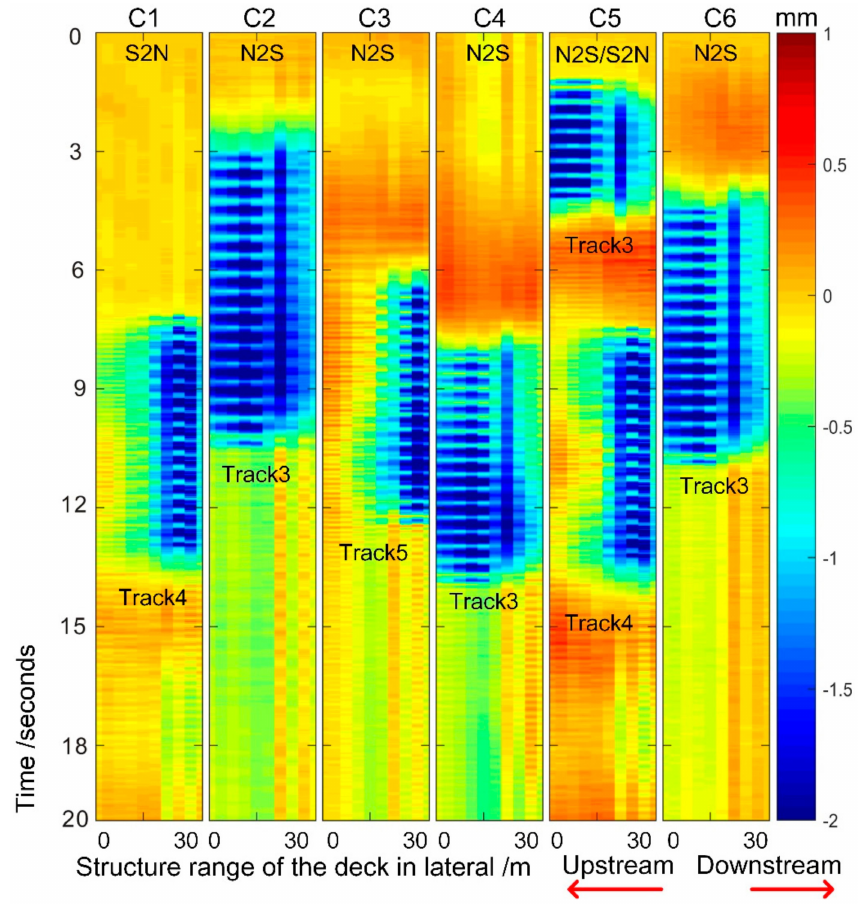
Figure 17. Vertical displacement map of the bridge deck near the expansion